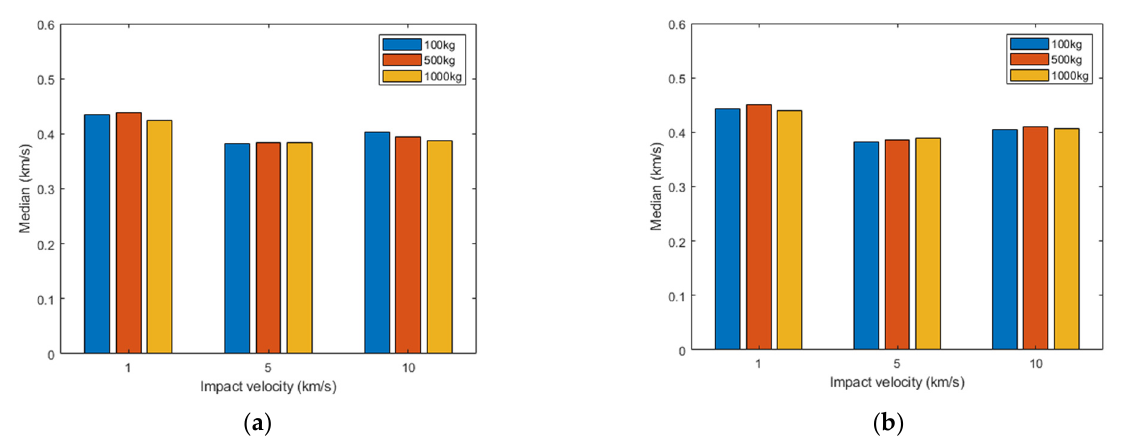
Figure 4. Median of target ( a ) and projectile ( b ) fragments sample velocities for different values of impact velocity and target mass. Mass of projectile is assumed to be 100 kg.